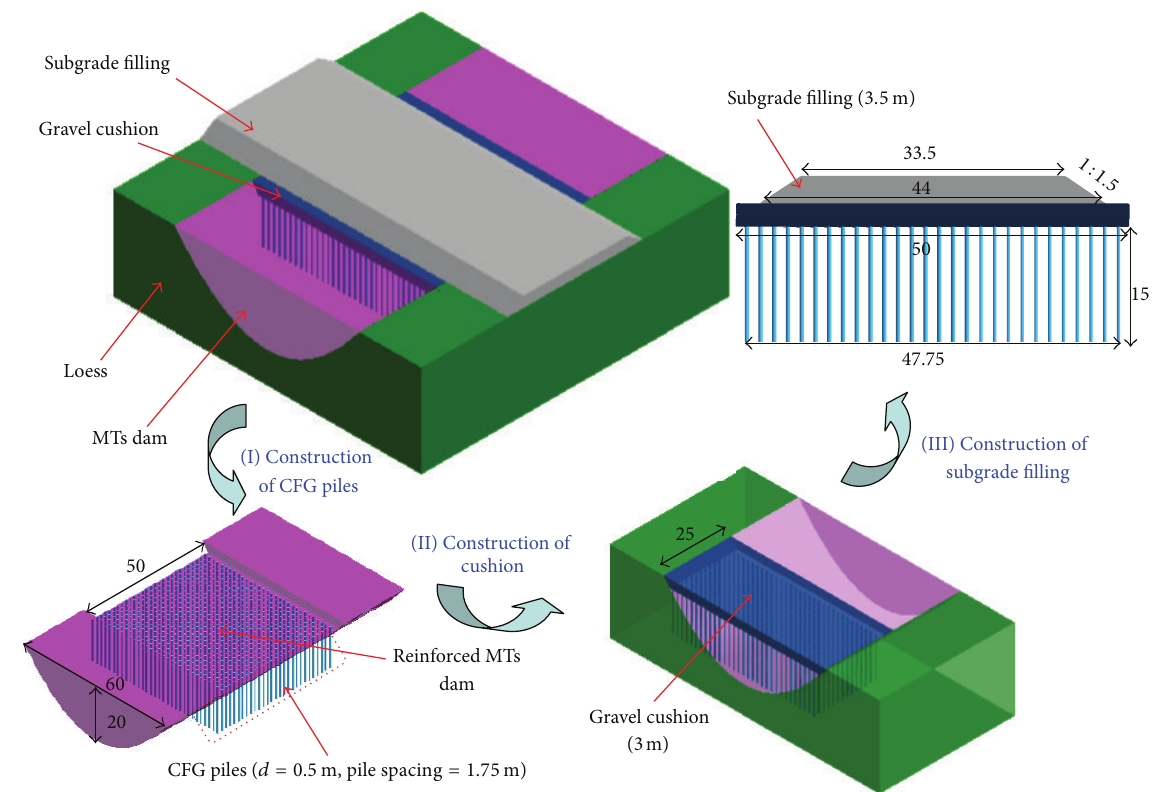
Figure 1: Diagram of CFG pile composite foundation (unit: